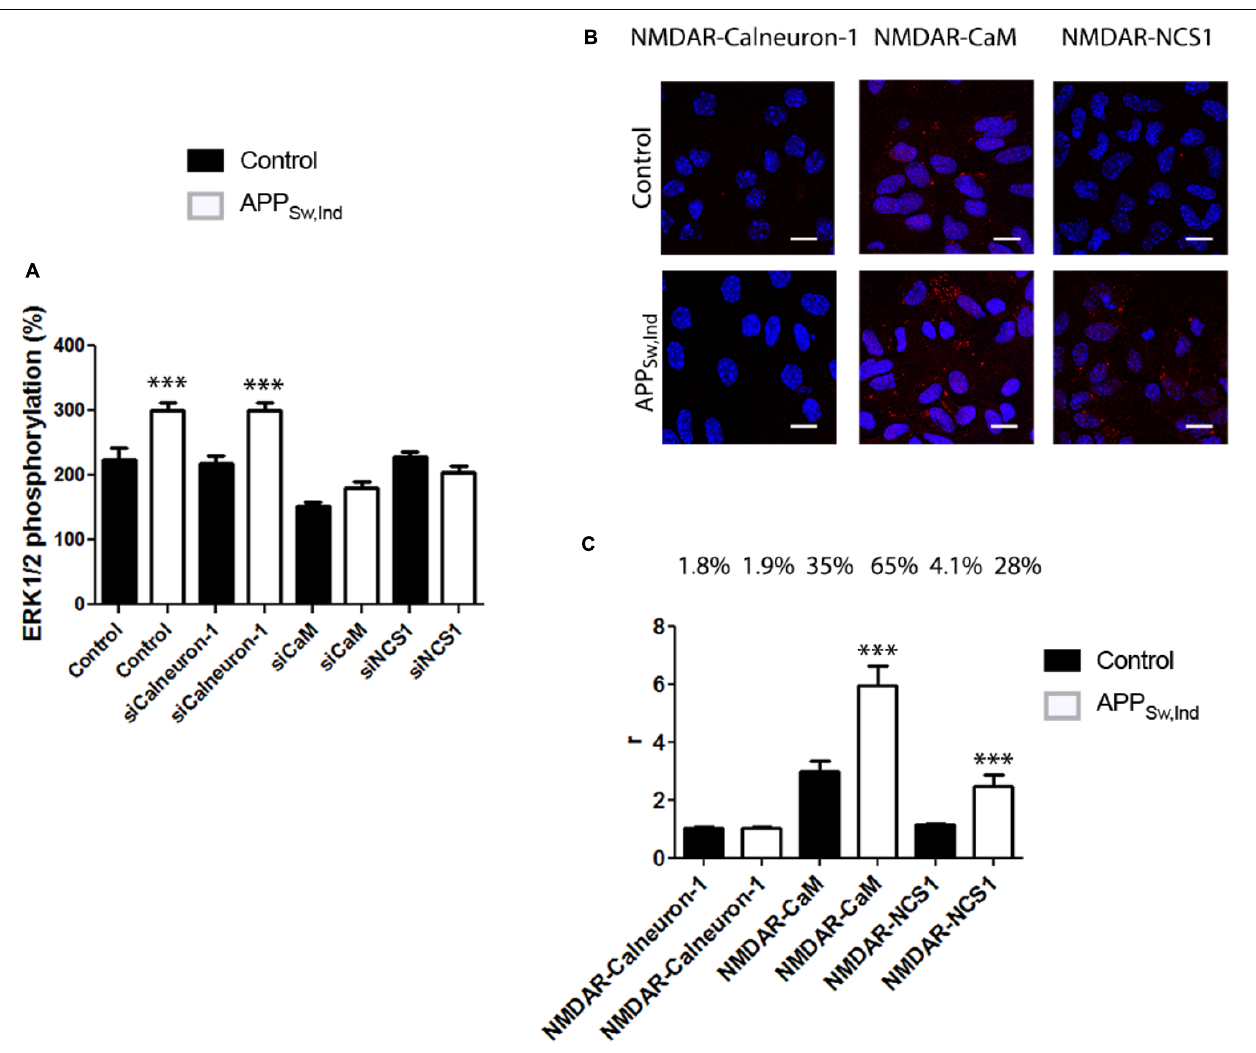
FIGURE 6 | NMDAR-mediated signaling in primary microglia from APP Sw , Ind mice. (A) Primary microglial cultures from non-transgenic control (black bars) and APP Sw , Ind (white bars) mice were isolated and transfected or not with siRNA for silencing calneuron-1, CaM, or NCS1. Microglia were treated with 15 µ M NMDA and MAPK phosphorylation was measured. Values are the mean ± SEM ( n = 6). One-way ANOVA followed by Bonferroni’s multiple comparison post hoc test were used for statistics analysis ( ∗∗∗ p < 0.001 versus control). (B) Primary microglial cultures from non-transgenic control (black bars) and APP Sw , Ind (white bars) mice were assayed for potential interactions between NMDAR and calcium sensors. PLA was performed using primary cultures of microglia and specific primary antibodies raised against NMDAR and calneuron-1, CaM, or NCS1. Confocal microscopy images (stacks of four consecutive planes) show heteroreceptor complexes as red clusters surrounding Hoechst-stained nuclei (blue). Scale bar: 10 µ m. The bar graph (C) shows the number of red dots/cell and the number above bars indicate the percentage of cells presenting red dots. Values are the mean ± SEM ( n = 6). One-way ANOVA followed by Bonferroni’s multiple comparison post hoc test was used for statistics analysis ( ∗∗∗ p < 0.001, comparing each condition versus control, i.e., comparing one by one white versus the corresponding black